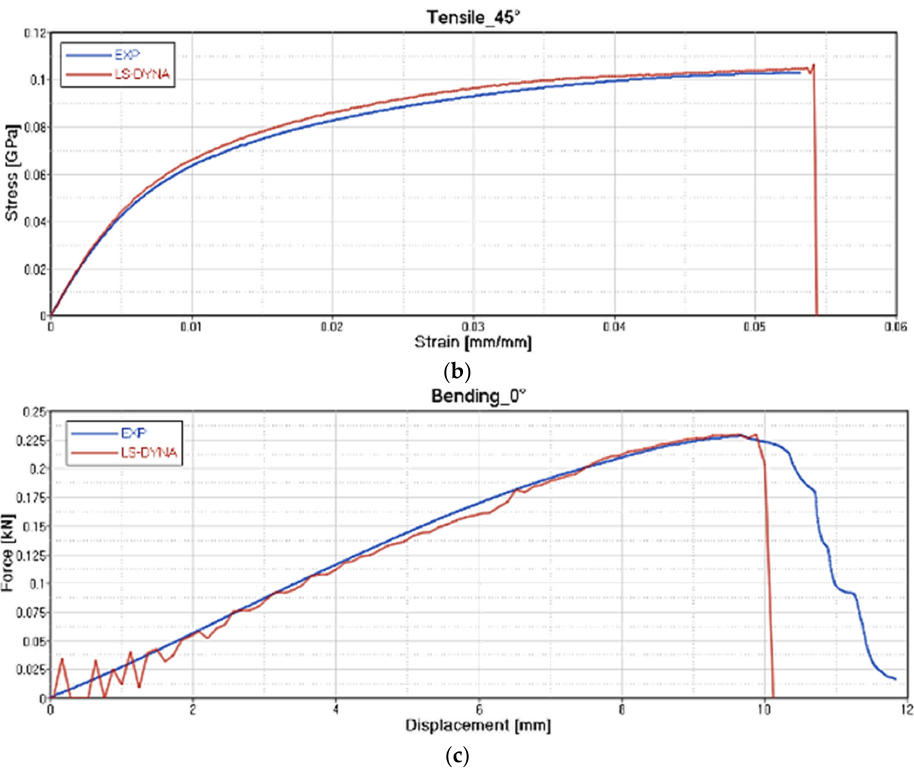
Figure 22. Correlation between experimental data and virtual material card setting for CF/EP-Angeloni. Tensile test at 0 ◦ (a ); Tensile test at 45 ◦ ( b ) and Force-Displacement (kN-mm) for Bending test at 0 ◦ ( c ).